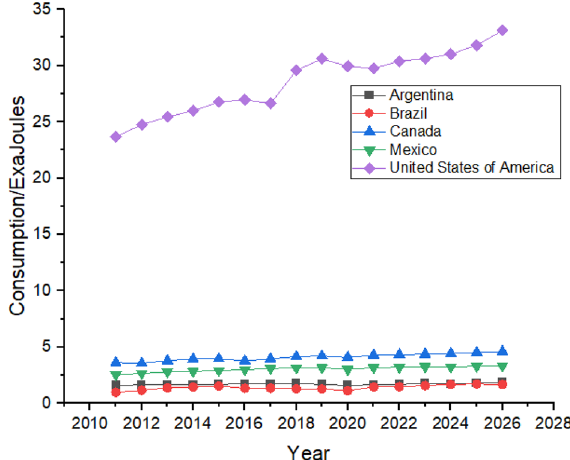
Figure 17. Natural gas consumption in American Region.